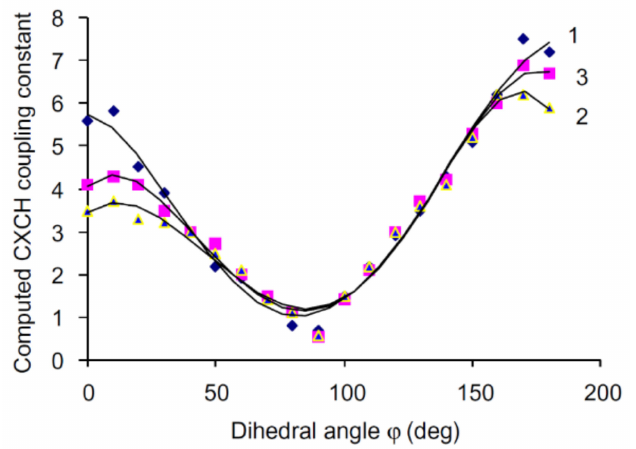
Figure 24. Dihedral angle dependence of vicinal carbon-hydrogen coupling constants calculated at the B3LYP/6-311++G(d,p) level in ( 1 )— O -glycosides; ( 2 )—thioglycosides; ( 3 )—glycosides. Repro- duced from Tafazzoli and Ghiasi [129] with the permission of Elsevier.